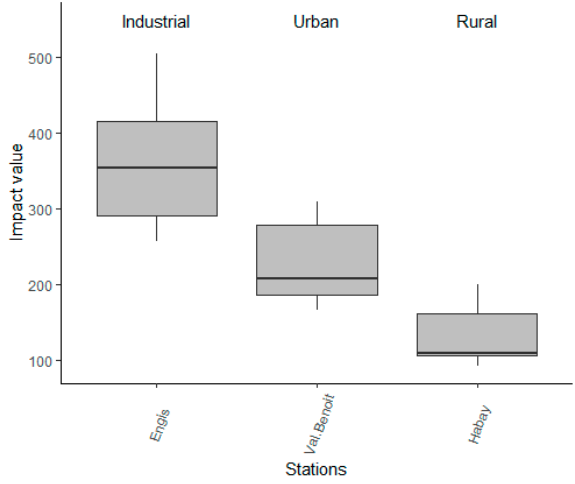
Figure 6. Distribution of the impact values from 2013 to 2019 of Engis, Val Benoit, and Habay air quality stations.